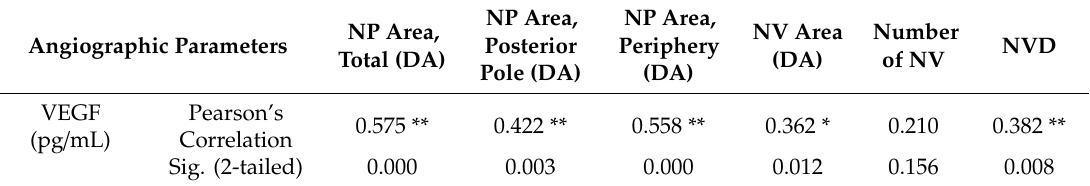
Table 4. Correlation between angiographic parameters and VEGF